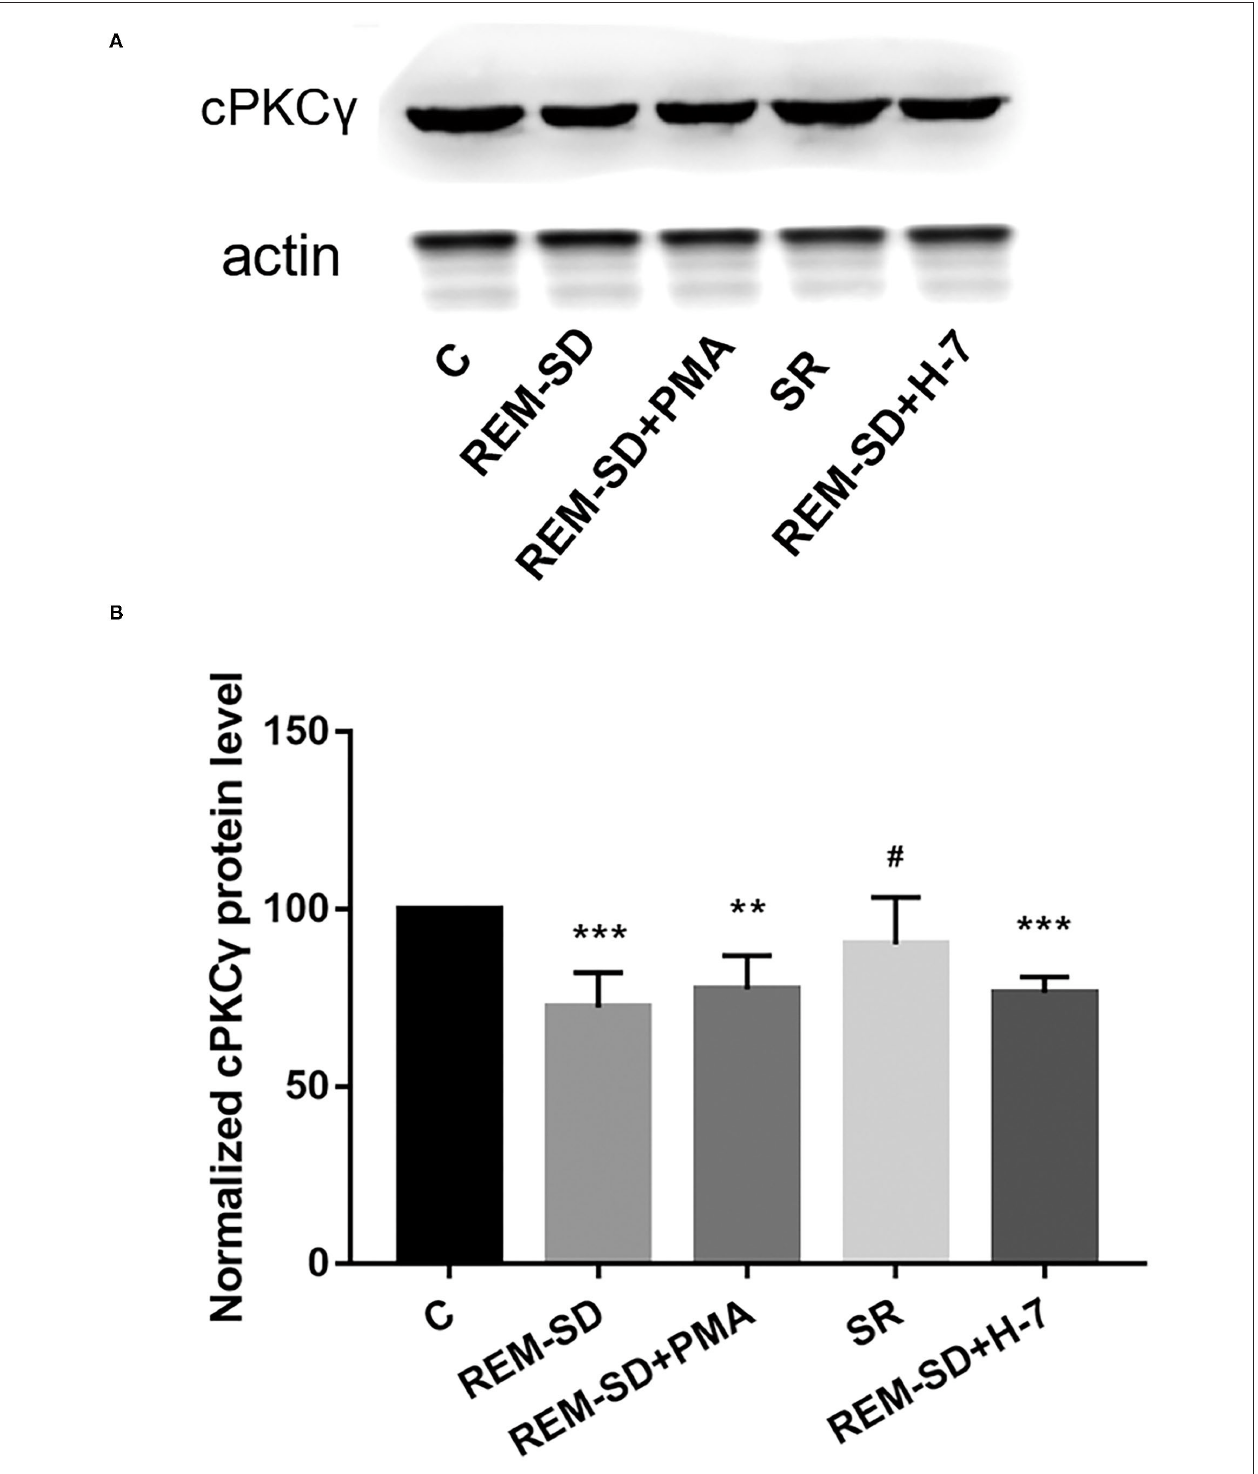
FIGURE 5 | cPKC γ protein expression in the prefrontal cortex of SD rats from each group and control group (C). (A) Western blot analysis results. (B) The relative protein expression of cPKC γ for each group. ** P < 0.01, *** P < 0.001 vs. control group; # P < 0.05 vs. SD group.